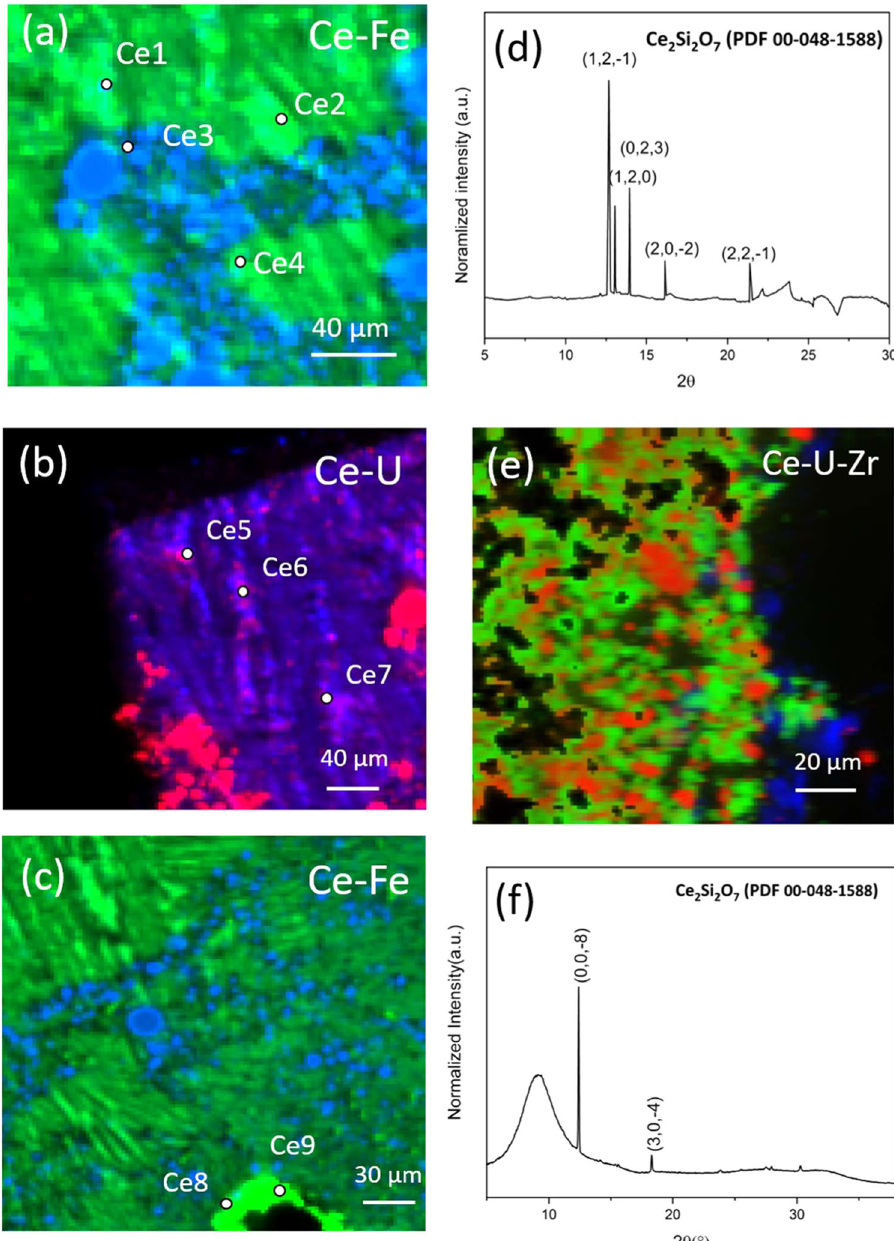
Fig. 10 µ-focus X-ray analysis of MCCI-2 and MCCI-3 Pu surrogates. Showing correlation maps obtained for MCCI-3 of the distribution of a Fe-K α (blue) and Ce-L α (green), b U-L α (blue) and Ce-L α (red) and c Fe-K α (blue) and Ce-L α (green), highlighting the positions of µ-XANES analysis in Fig. 11; d µ-XRD close to point Ce8 indexed as Ce 2 Si 2 O 7 (PDF #00-048-1588); e U-L α (red), Zr-K α (green) and Ce-L α (blue) X-ray fl uorescence signals, and f a single pixel µ-XRD pattern indexed as Ce 2 Si 2 O 7 (PDF #00-048-1588). Scale bars are as follow: a and b 40 µm; c 30 µm; and e 20